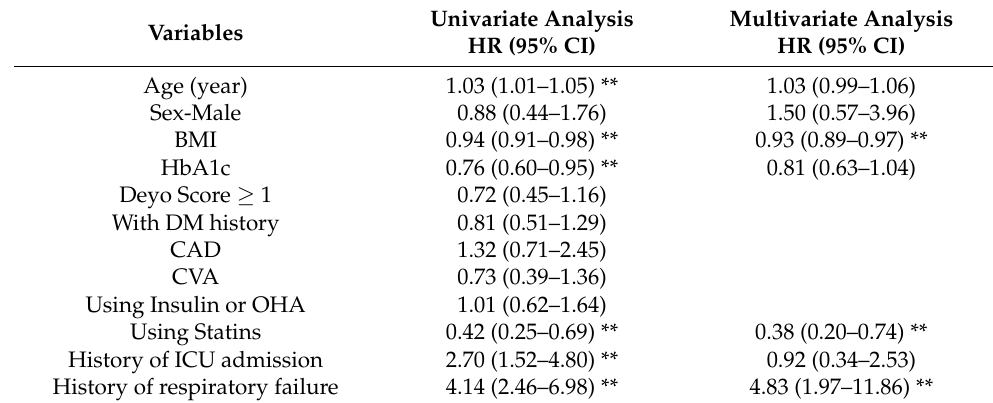
Table 3. Cox analysis of factors associated with long-term outcome in aged COPD patients required